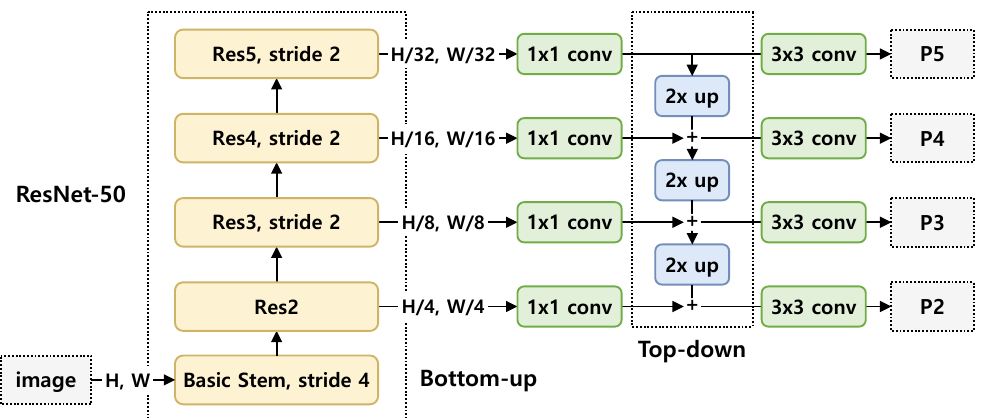
respectively. In (2), ResNet-50-FPN-HIHNet ( · ) means the combination of the backbone and human instance head networks.